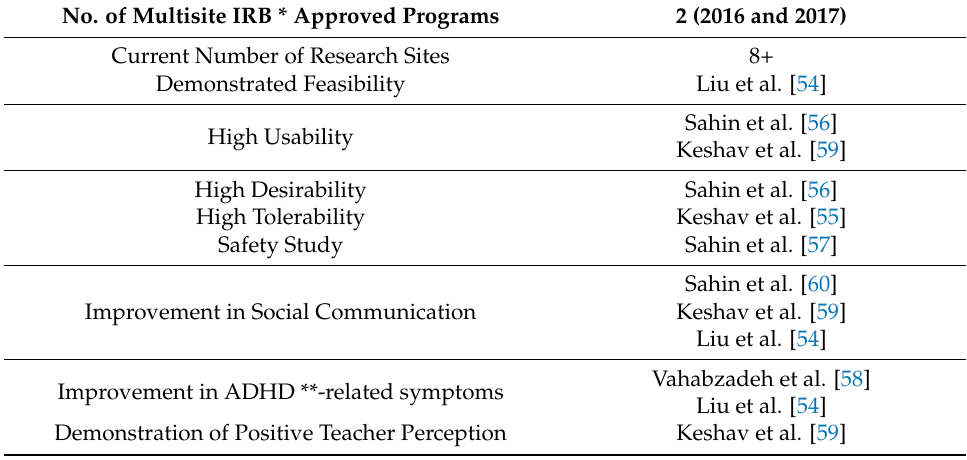
Figure 1. ( A ) Student with Autism Spectrum Disorder (ASD) wears Empowered Brain as he interacts with educator during a 10-min intervention in a typical classroom setting. ( B ) Student looking at display screen of Empowered Brain. ( C ) Screenshot of one of the Empowered Brain apps as would be seen on the optical display of smartglasses. ( D ) Example of the Face2Face app, a game-like experience designed to improve facial attention and mutual eye gaze. ( E ) Example screenshot of Emotion Charades app, a game-like experience that improves emotional understanding through the use of emotional artificial intelligence. ( F ) Example of metrics and qualitative session and student data captured and analyzed by data portal. ( G ) Generation of customized reports for student Individualized Education Programs (IEP) demonstrating learning and skill development. Table 1. Research background and peer-reviewed research findings related to Empowered